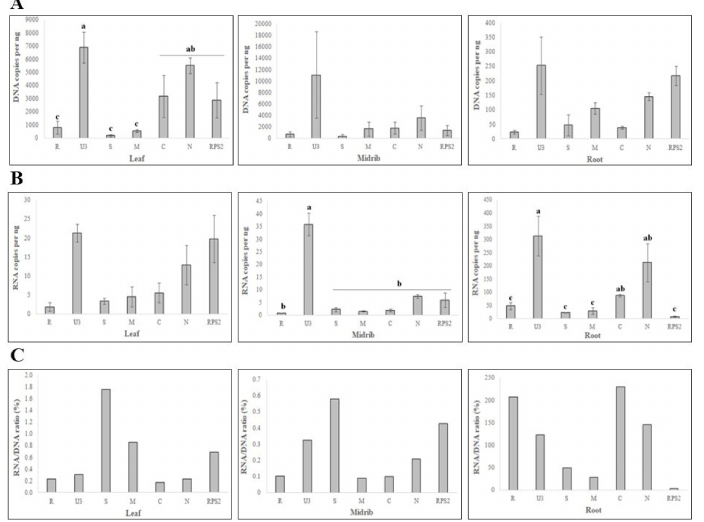
Figure 2. Quantification of DNA and RNA copies per ng of each genomic component of BBTV.